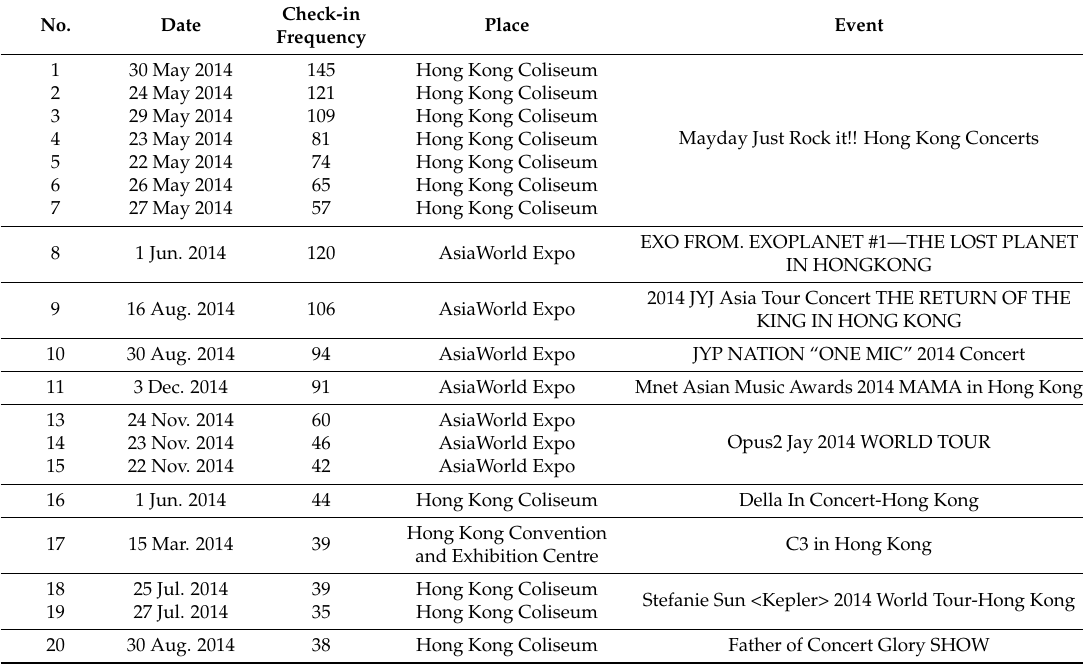
Table 6. The twenty most frequent check-in dates and the corresponding special events.